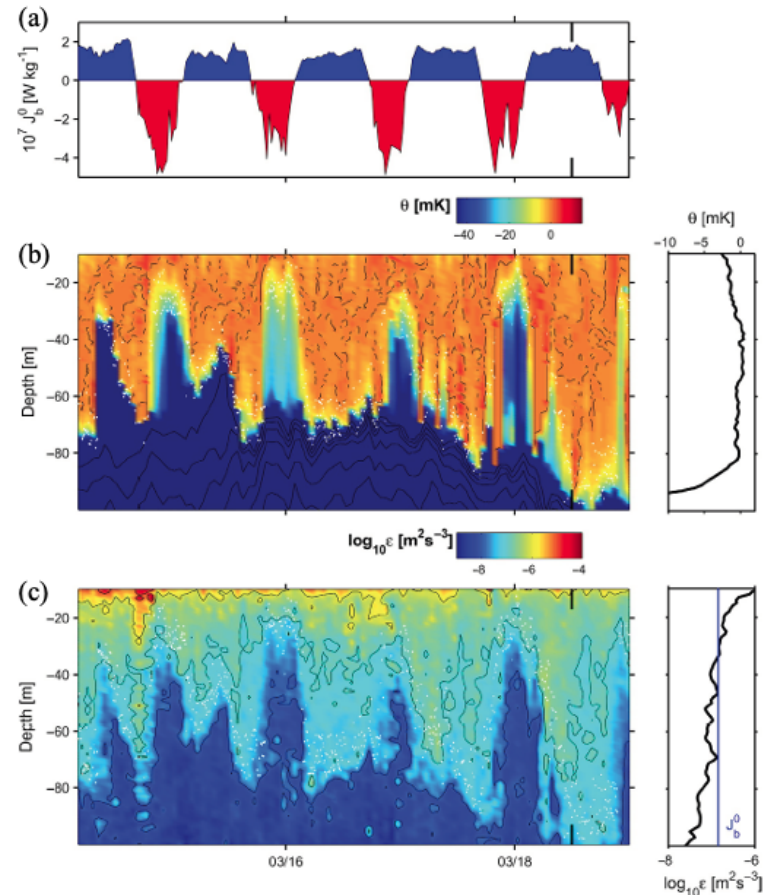
Figure 2. Mixed layer convection from observations taken in the North Pacific Ocean. A vertical turbulence profiler and shipboard meteorological sensors took the data over a five day period in March 1987. ( a ) Surface buoyancy flux primarily consisting of day-time heating (red) and night-time cooling (blue). ( b ) Potential temperature shown relative to the individual profile mean to better display the vertical structure. Additionally included is the averaged vertical profile, taken at the time interval shown by the vertical bars at the top and bottom of the main panel. ( c ) Viscous dissipation rate of turbulence kinetic energy. Additionally included is the averaged profile with the vertical blue line showing the mean of the surface buoyancy flux. The small white dots in the depth-time panels show the mixed layer depth measured using the individual profiles. Reproduced with permission from Moum et al. [1], published by Elsevier